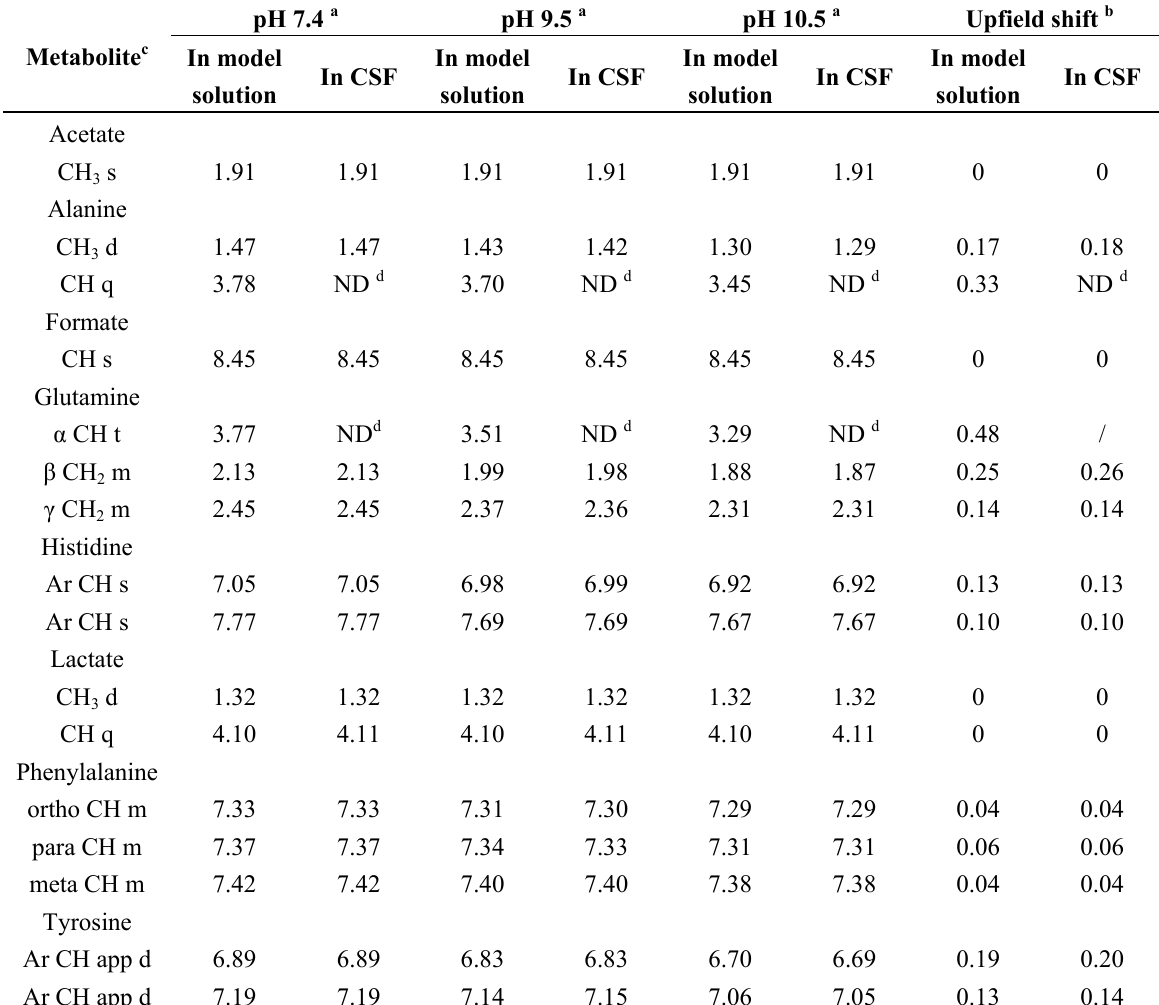
Table 1. Chemical shifts ( δ ) of some cerebrospinal fluid samples (CSF) metabolites discussed in this study as a function of pHs in the range